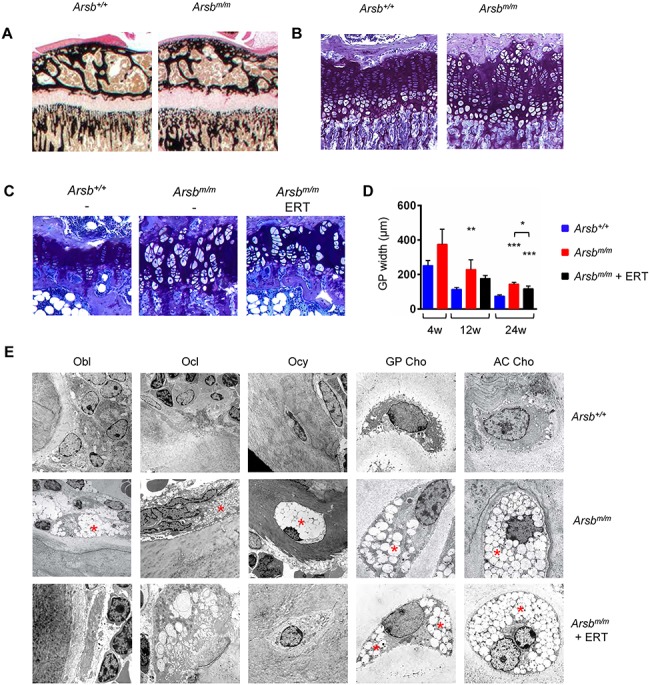
Chondrocyte pathologies in Arsb-deficient mice are not affected by ERT. (A) Representative images showing the width of the growth plates in undecalcified tibia sections from 4-week-old wild-type (Arsb+/+) and Arsb-deficient mice (Arsbm/m) after von Kossa-van Gieson staining. (B) Representative images showing the growth plates in tibia sections from the same animals after toluidine blue staining. (C) Representative images showing the growth plates in tibia sections from 24-week-old wild-type (Arsb+/+), untreated (Arsbm/m) or treated (Arsbm/m ERT) Arsb-deficient mice after toluidine blue staining. (D) Quantification of growth plate (GP) width in tibia sections from wild-type (blue bars), untreated (red bars) or treated (black bars) Arsb-deficient mice at 4, 12 or 24 weeks of age (n ≥ 5 mice per group). (E) Representative electron microscopy images showing osteoblasts (Obl), osteoclasts (Ocl), osteocytes (Ocy), and chondrocyte in the growth plate (GP Cho) or articular cartilage (AC Cho) from 12-week-old wild-type (Arsb+/+), untreated (Arsbm/m) or treated (Arsbm/m ERT) Arsb-deficient mice. Lysosomal storage is indicated by the asterisks. Data are expressed as mean ± SD. *P < 0.05, **P < 0.005, ***P < 0.0005 (one-way ANOVA).